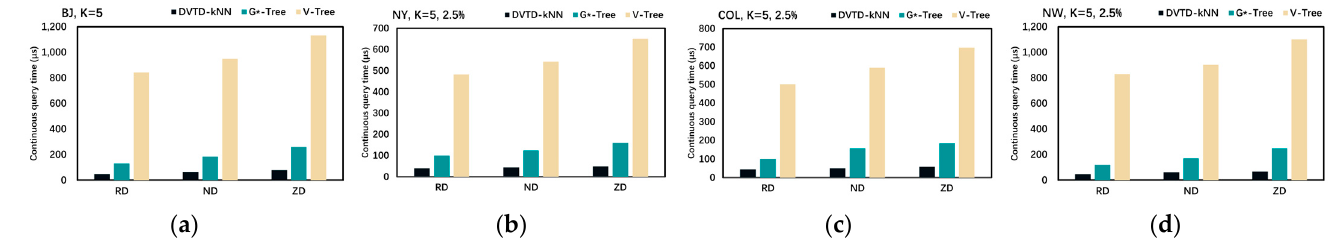
Figure 16. Comparison of query times between baseline algorithms and DVTG-C k NN under the three distribution strategies. ( a ) Query times on BJ; ( b ) Query times on NY; ( c ) Query times on COL; ( d ) Query times on NW.